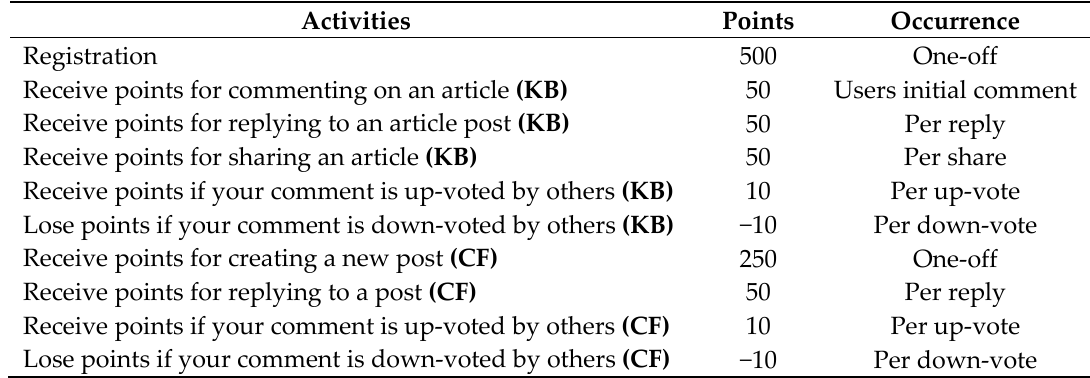
Table A2. Gamification–points scoring.